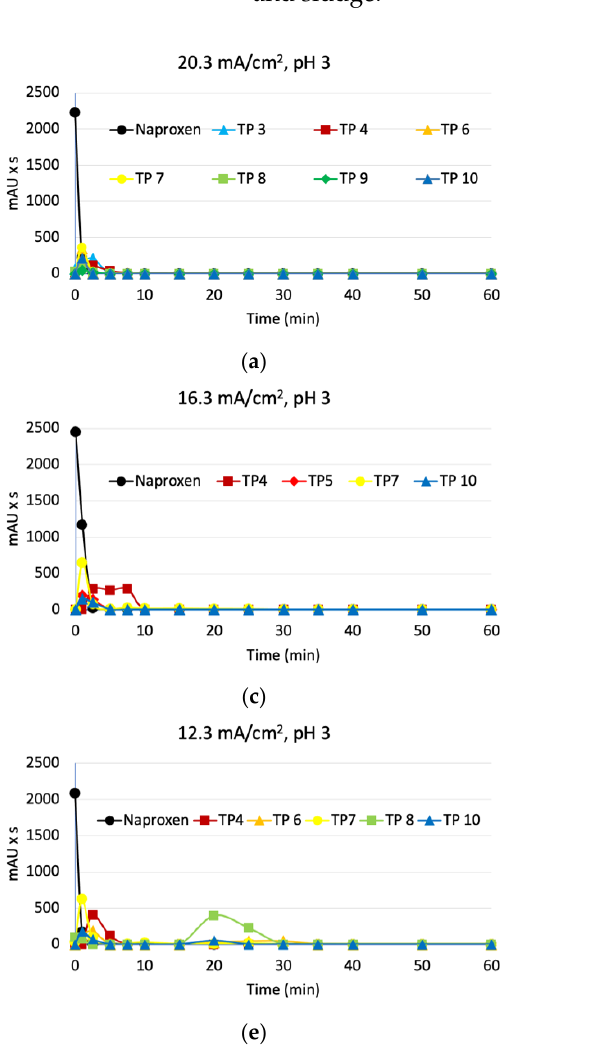
Figure 7. Naproxen transformation products detection in the sludge and electrochemical oxidation under different current densities and pH conditions. The figure shows the average of three replicates. ( a ) 20.3 mA/cm 2 and pH 3; ( b ) 20.3 mA/cm 2 and pH 9; ( c ) 16.3 mA/cm 2 and pH 3; ( d ) 16.3 mA/cm 2 and pH 9; ( e ) 12.3 mA/cm 2 and pH 3; ( f ) 12.3 mA/cm 2 and pH 9.